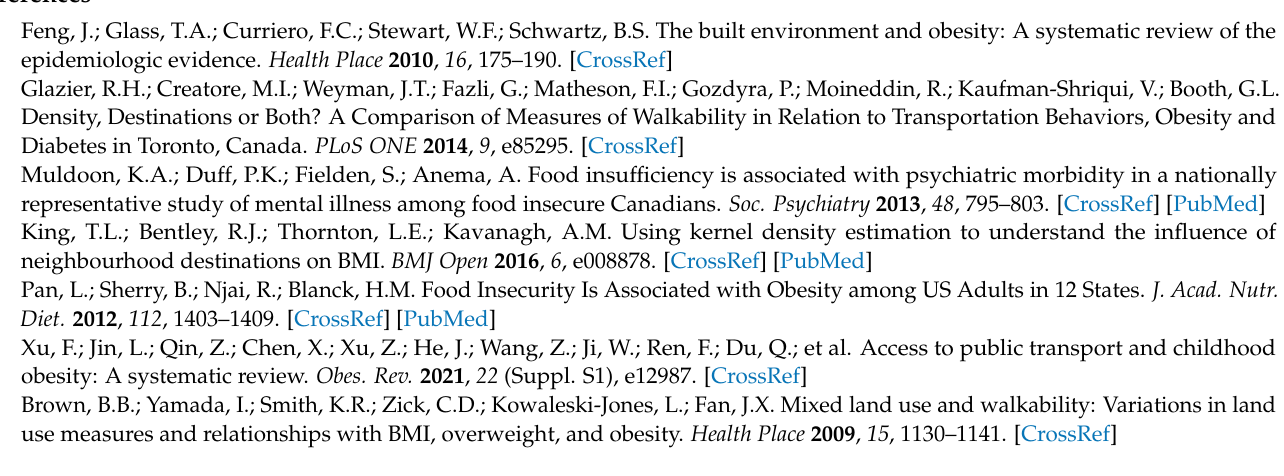
health. Figure S2: Unadjusted piecewise linear spline models visualizing the relationships between NAS and mental and physical health for White (gray lines) and non-White (black lines)